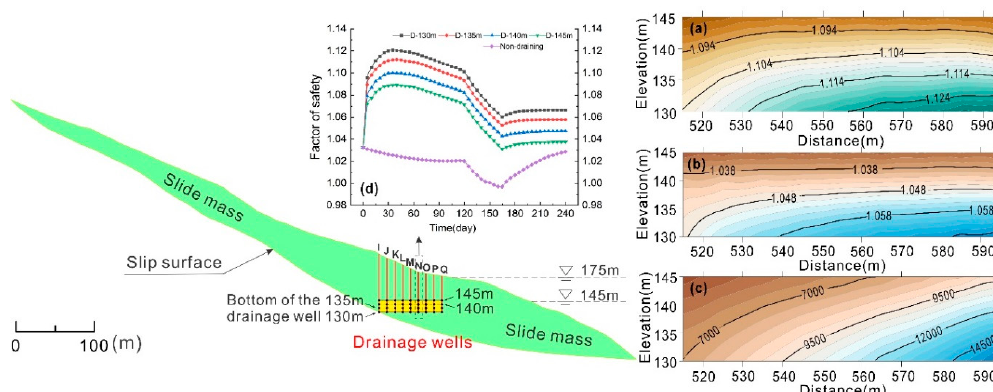
Figure 10. Variation of the landslide stability for draining wells at various depths. ( a ) Contour map of maximum safety factor during draining and reservoir level variation. ( b ) Contour map of minimum safety factor during draining and reservoir level variation. ( c ) Contour map of cumulative discharge during draining and reservoir level variation. ( d ) Variation of the landslide stability under well drainage at various depths with a horizontal location of 565 m.